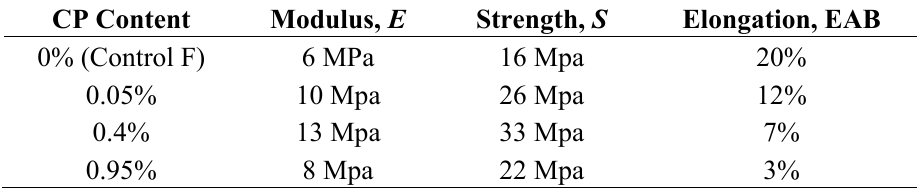
Table 3. The average tensile properties of E films at ~35% RH as a function of CP